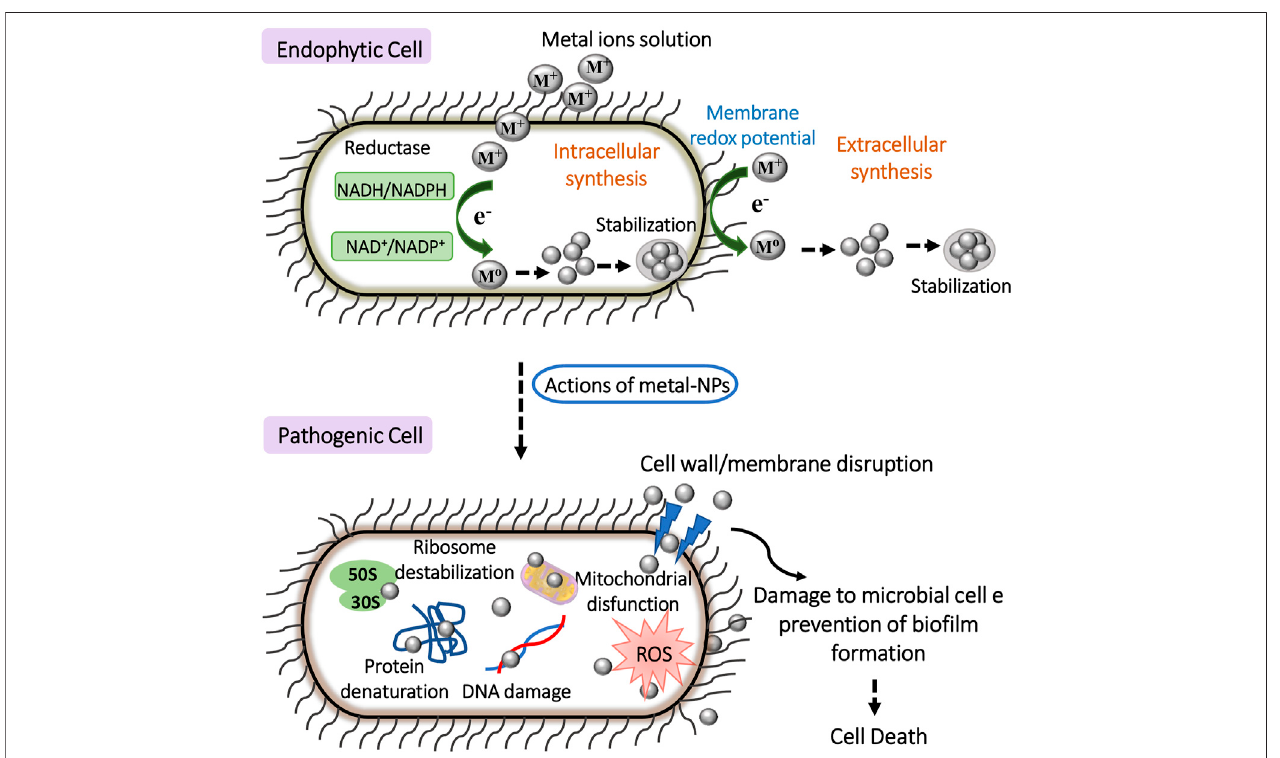
FIGURE2| Schematicrepresentationofgeneralantimicrobialmechanismsofmetal-basedNPssynthetizedbyintra-orextracellularmechanismsusingendophytic cells. The adherence of NPs to pathogen surface cause multiple damage to cellular machinery, inhibit bacterial growth and bio fi lm formation, and promote cell death.